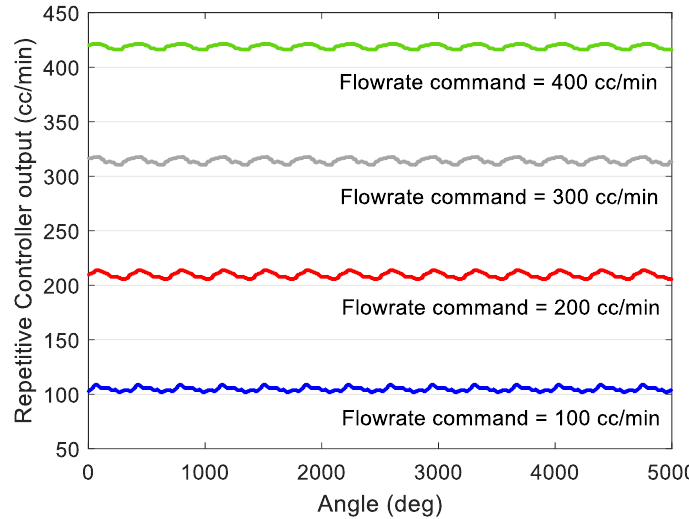
Figure 8. Repetitive controller output at the steady state for various references.